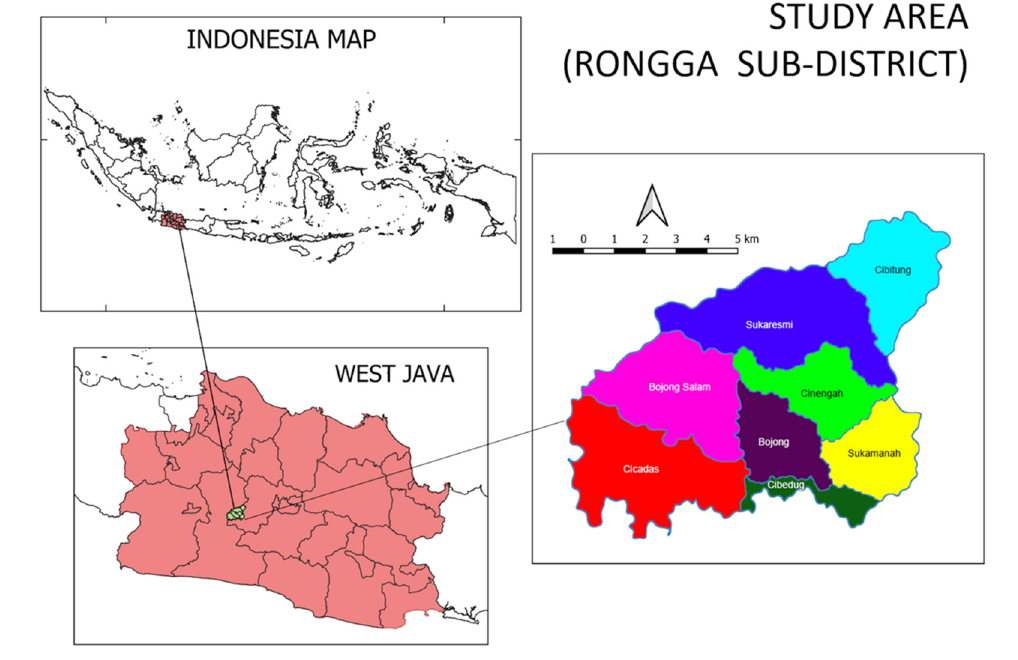
Figure 1. Borders of Rongga Sub-district (Source [25]).